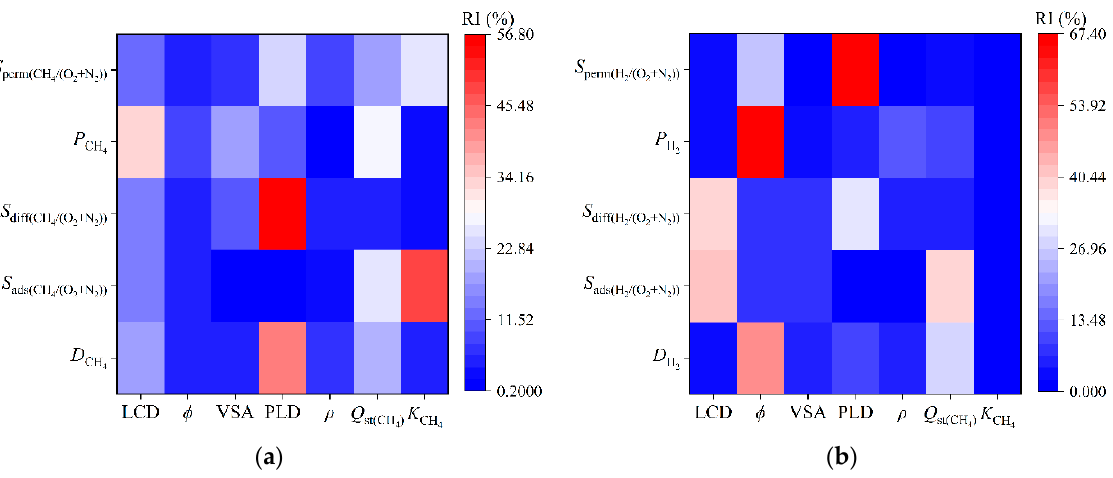
Figure 4. Relative importance values of the seven descriptors predicted by the RF algorithm for: ( a ) CH 4 /O 2 + N 2 ; and ( b ) H 2 /O 2 + N 2 .